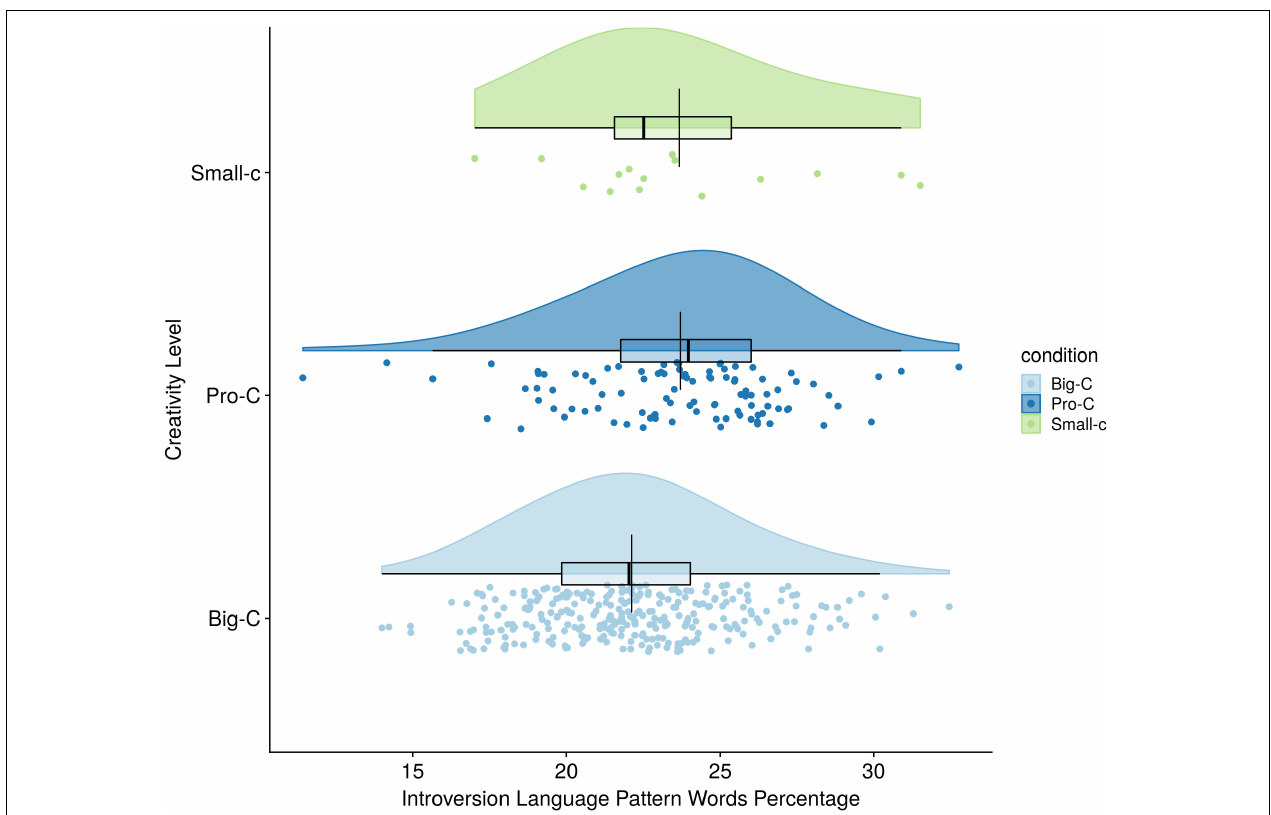
FIGURE 3 | Creativity level differences on introversion language pattern